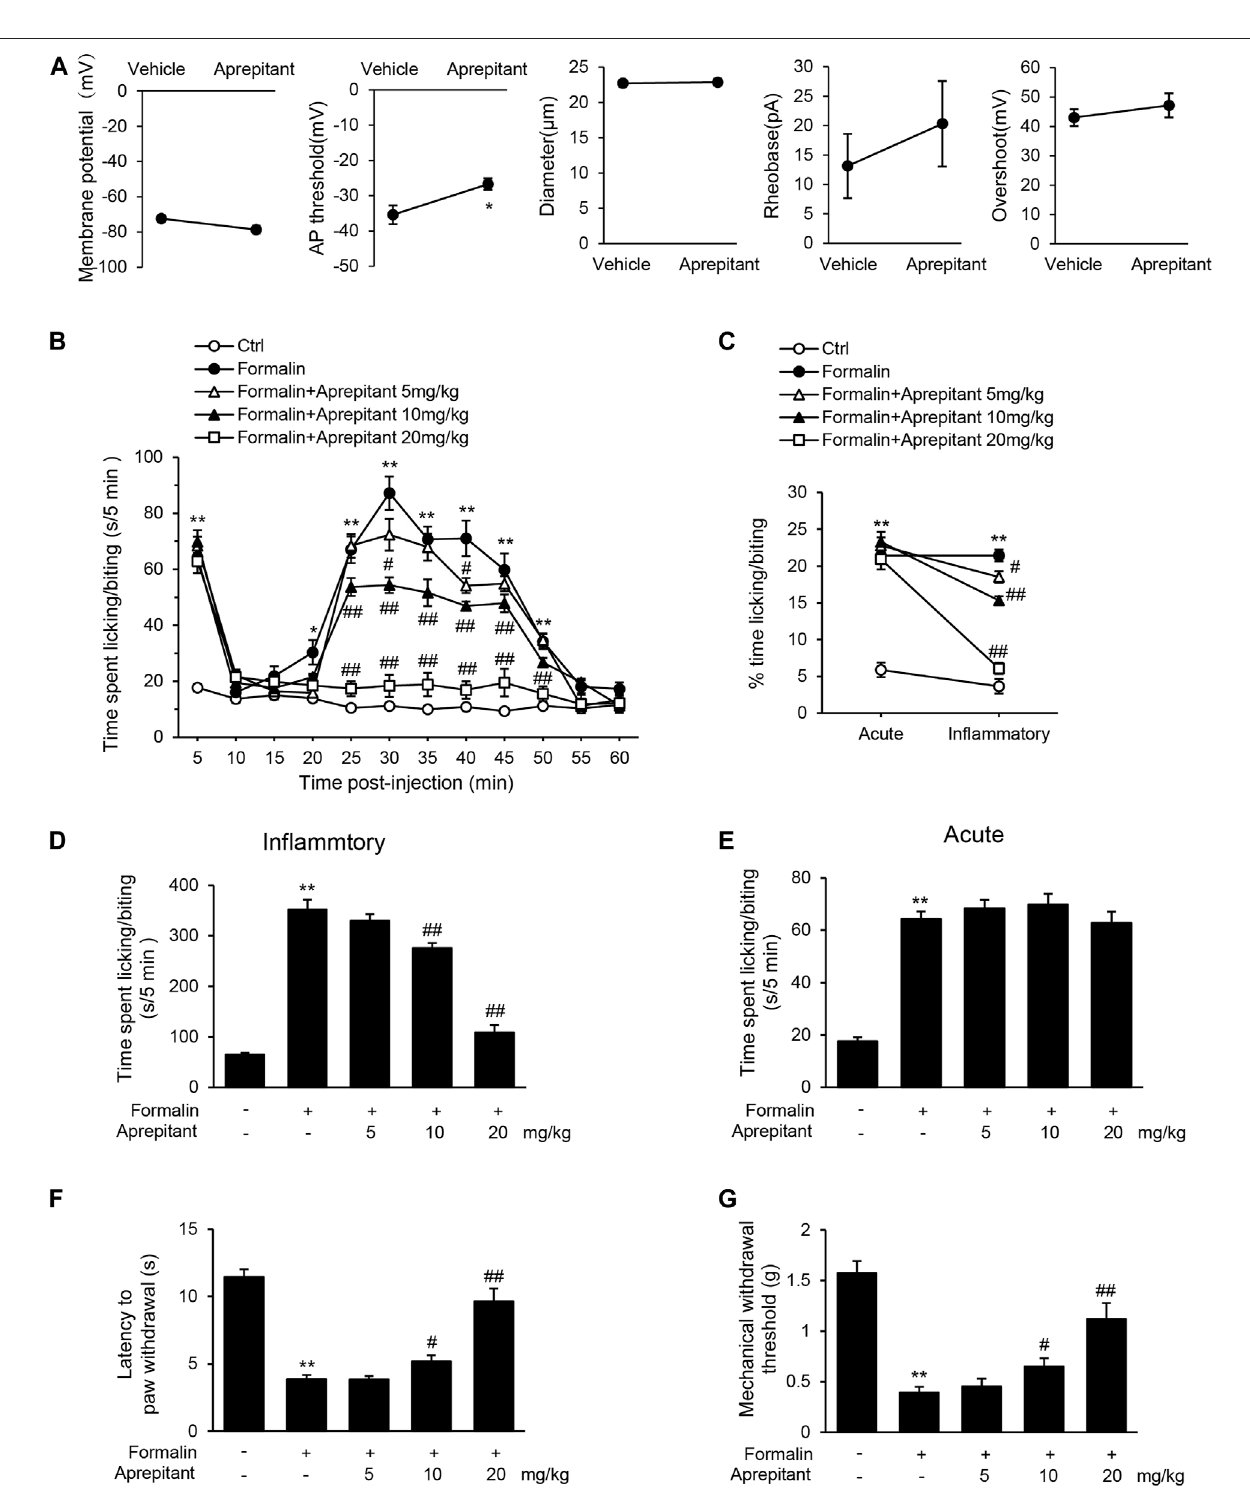
FIGURE1| Aprepitantattenuatedresponsetoin fl ammatorypain. (A) MembranepropertiesofDRGneuronsincontrolandaprepitant(2 μ M)treatmentgroups.AP, action potential; Rheobase, the minimum current required to trigger an AP. Statistical signi fi cance was evaluate by the unpaired Student ’ s t test. (B) Time spent licking paw following formalin injection displayed in 5-min time bins after single injection of aprepitant. (C) % time spent paw licking during acute and in fl ammatory phases of formalintestwithaprepitanttreatment. (D) Timespentpawlickingduringthein fl ammatoryphaseofformalintest. (E) Timespentpawlickingduringtheacutephase offormalintest. (F) Latencytowithdrawpawinaprepitanttreatmentgroupsversuscontrolmiceduringhotplatetest. (G) Withdrawalthreshold(VonFrey fi lamentatwhich mouserespondedto > 50%oftrials)inaprepitanttreatmentgroupsversuscontrolmice.Twelvemicewereincludedineachofthegroups( n (cid:1) 12).Dataareexpressedas mean ± SEM. Two-way ANOVA, * p < 0.05, ** p < 0.01 versus vehicle or control, # p < 0.05, ## p < 0.01 versus formalin.